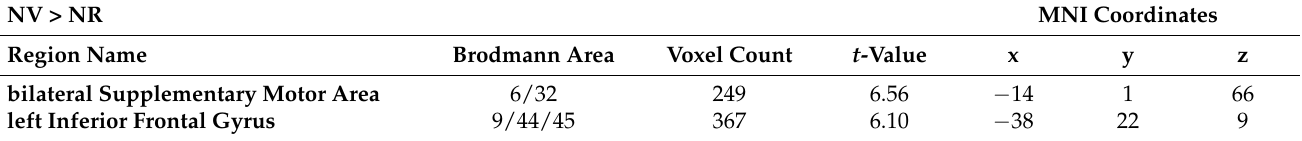
Table 2. Activation peaks and extents for NV > NR.